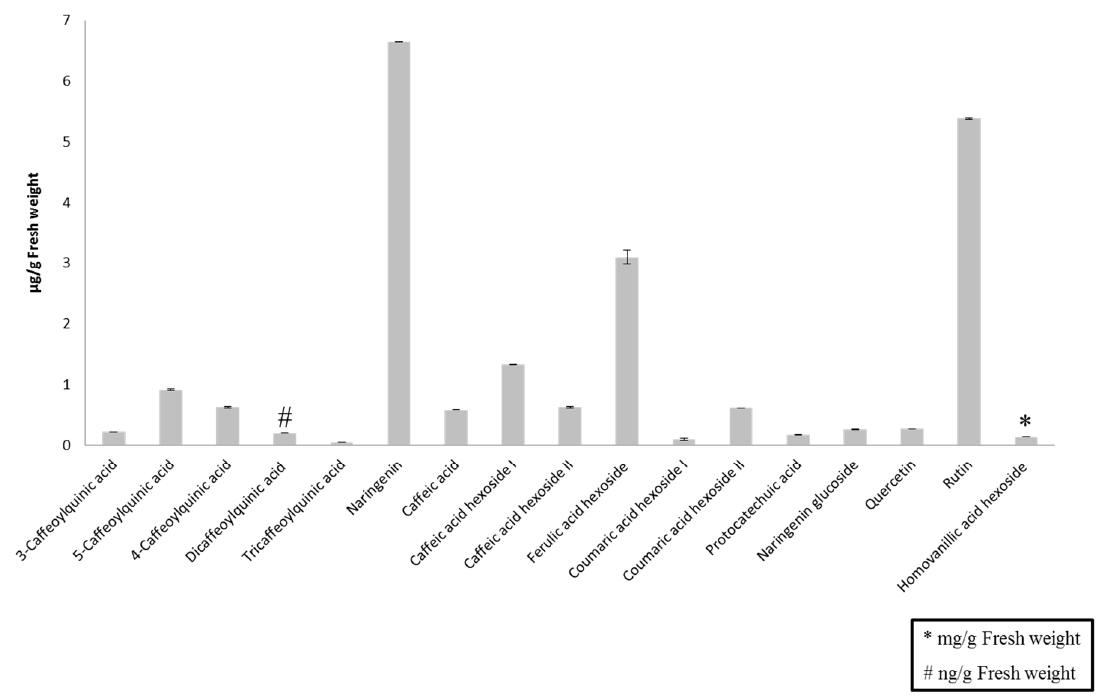
Figure 2. Quantification of phenolic compounds from tomato sauce administered to the volunteers by UHPLC-MS/MS analysis. Values are mean ± standard deviation (µg/g FW). Diccaffeoylquinic acid was expressed as ng/g FW and homovanillic acid hexoside as mg/g FW.